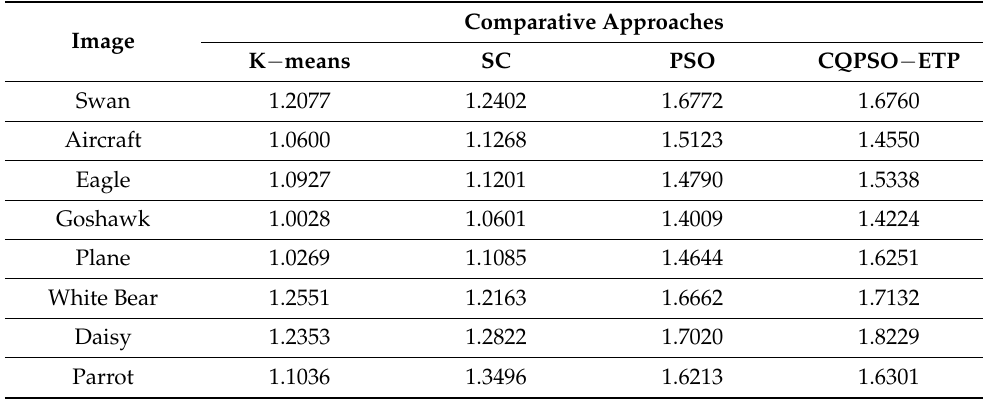
Table 9. Mean time taken by comparative approaches on eight tested images (Units: second).